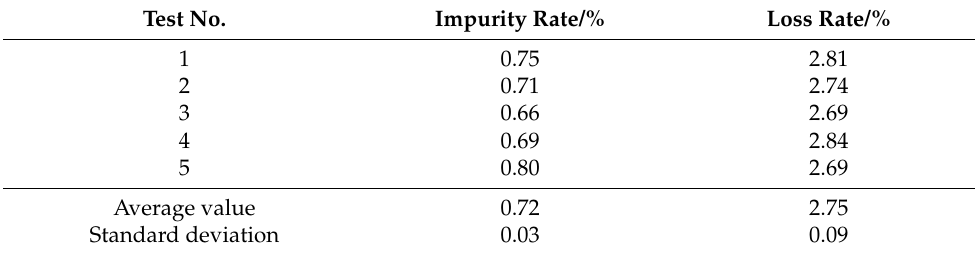
Table 7. Results of verification test. Test